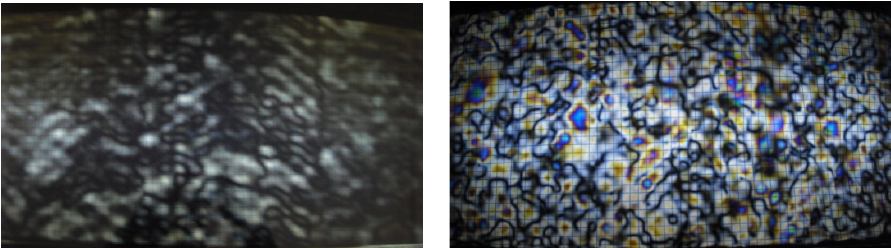
Figure 8a and b: polarization filter pictures of toughened bent glass specimens with a) uniform and b) non- uniform pre-stress